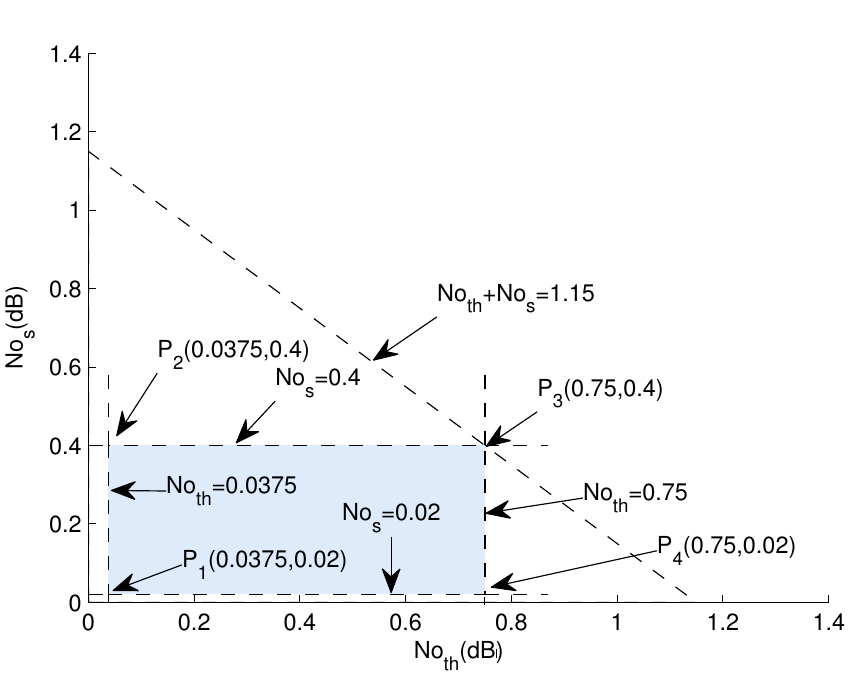
Figure 8. Noises Feasible